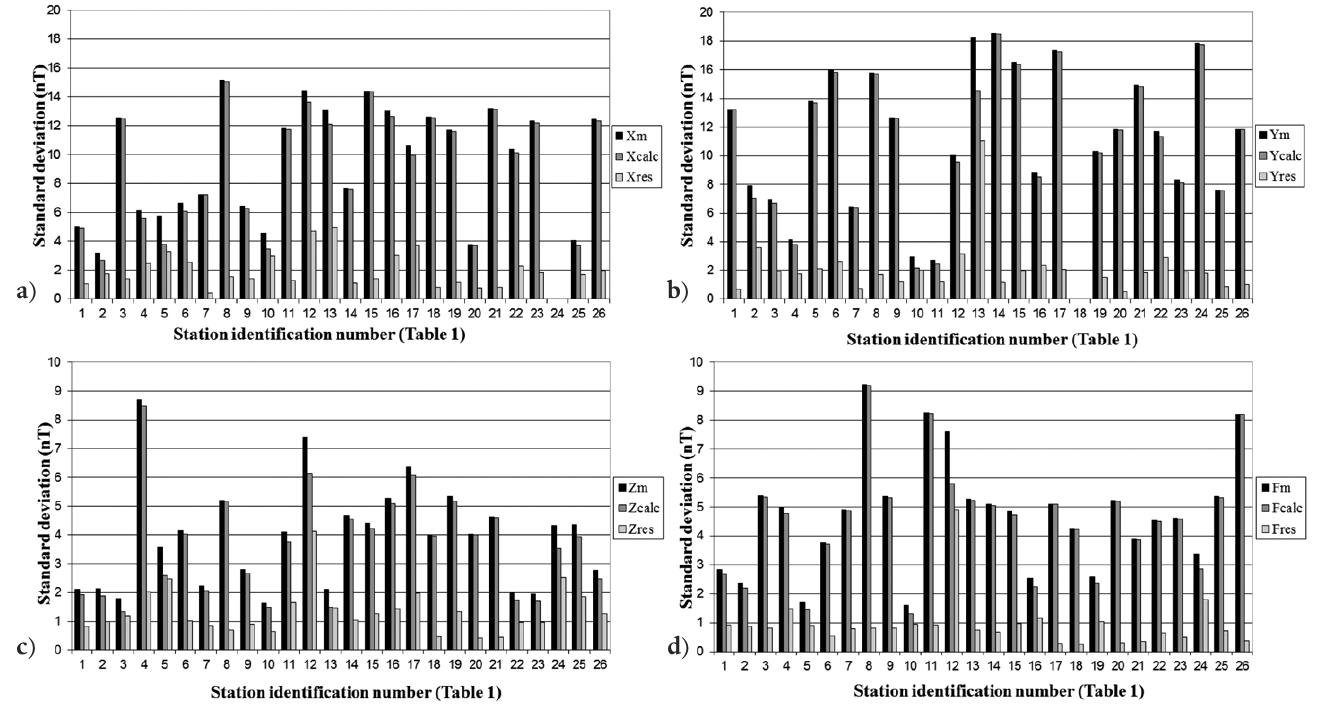
Figure 5. Standard deviation about the mean of raw (measured) data, calculated values of the magnetic induction model, and model residuals for the 26 stations of the repeat network (identification numbers as in Table 1). a) X; b) Y; c) Z; d)